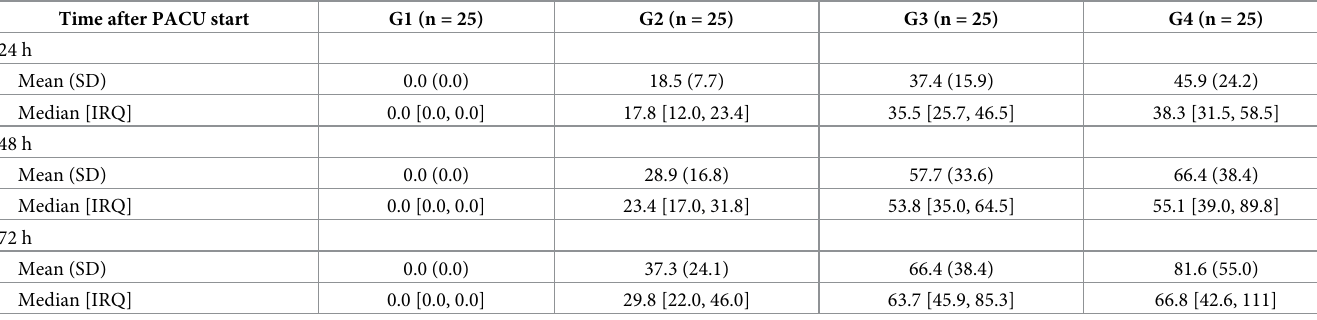
Table 3. Cumulative S-ketamine consumption during the study after the beginning of PACU care. Time after PACU